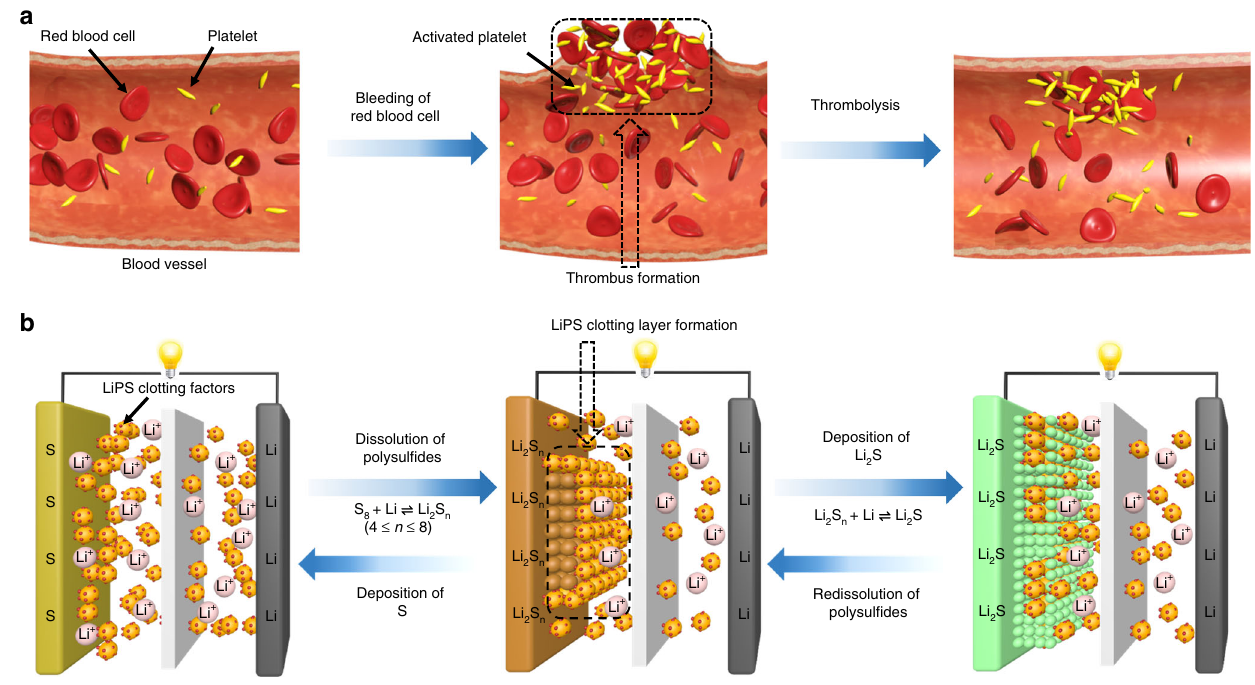
Fig. 1 Schematics of the blood coagulation and LiPS clotting mechanisms. a In mammals, when an injury happens in a vessel wall, the platelets become activated, triggering the formation of thrombus to stanch bleeding. After the wound is healed, thrombolysis occurs spontaneously. b Diffusion of LiPS in Li – S batteries can be effectively restrained by a recoverable protective clotting layer formed in situ from the reaction between dissolved LiPS and LiPS clotting factors at the electrode – electrolyte interface during the discharge/charge process.